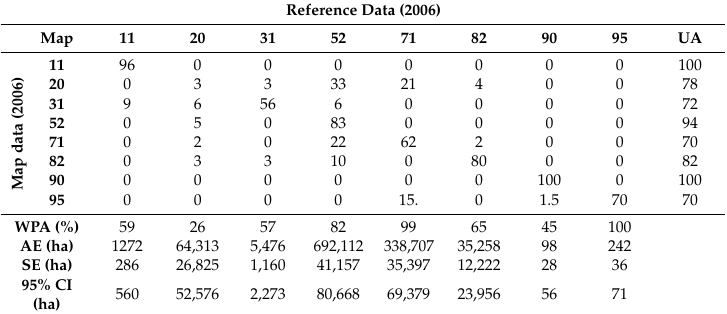
Table A7. Error matrix of Lea County (2006) expressed by Area Weighted Proportions